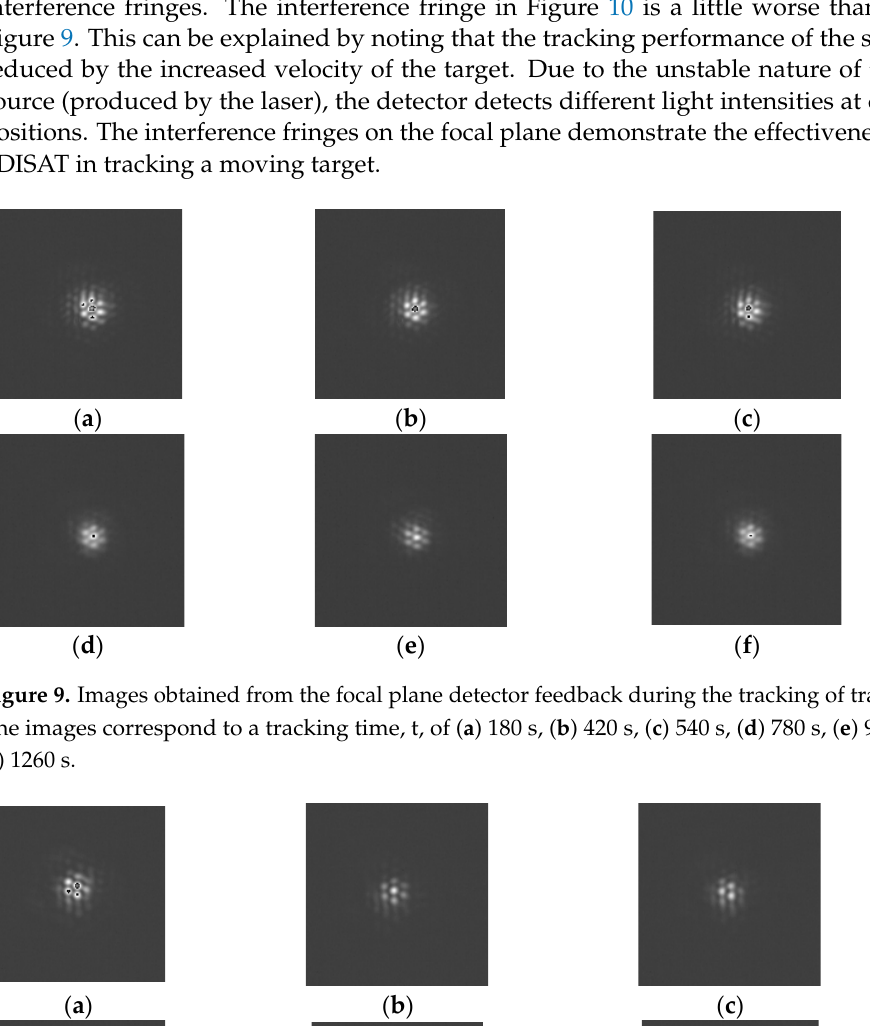
( d ) Figure 8. The tracking error as a function of time for each sub-aperture for ( a ) x-direction of trajec- tory-1 , ( b ) y-direction of trajectory-1 , ( c ) x-direction of trajectory-2 , ( d ) y-direction of trajectory- 2 . Table 3. RMSE of tracking for each sub-aperture. Veloci- tyZHANG- ZHEN(°/s) Aperture RMSE Trkx (arcsec) RMSE Trky (arcsec) RMSE Trkr (arcsec)